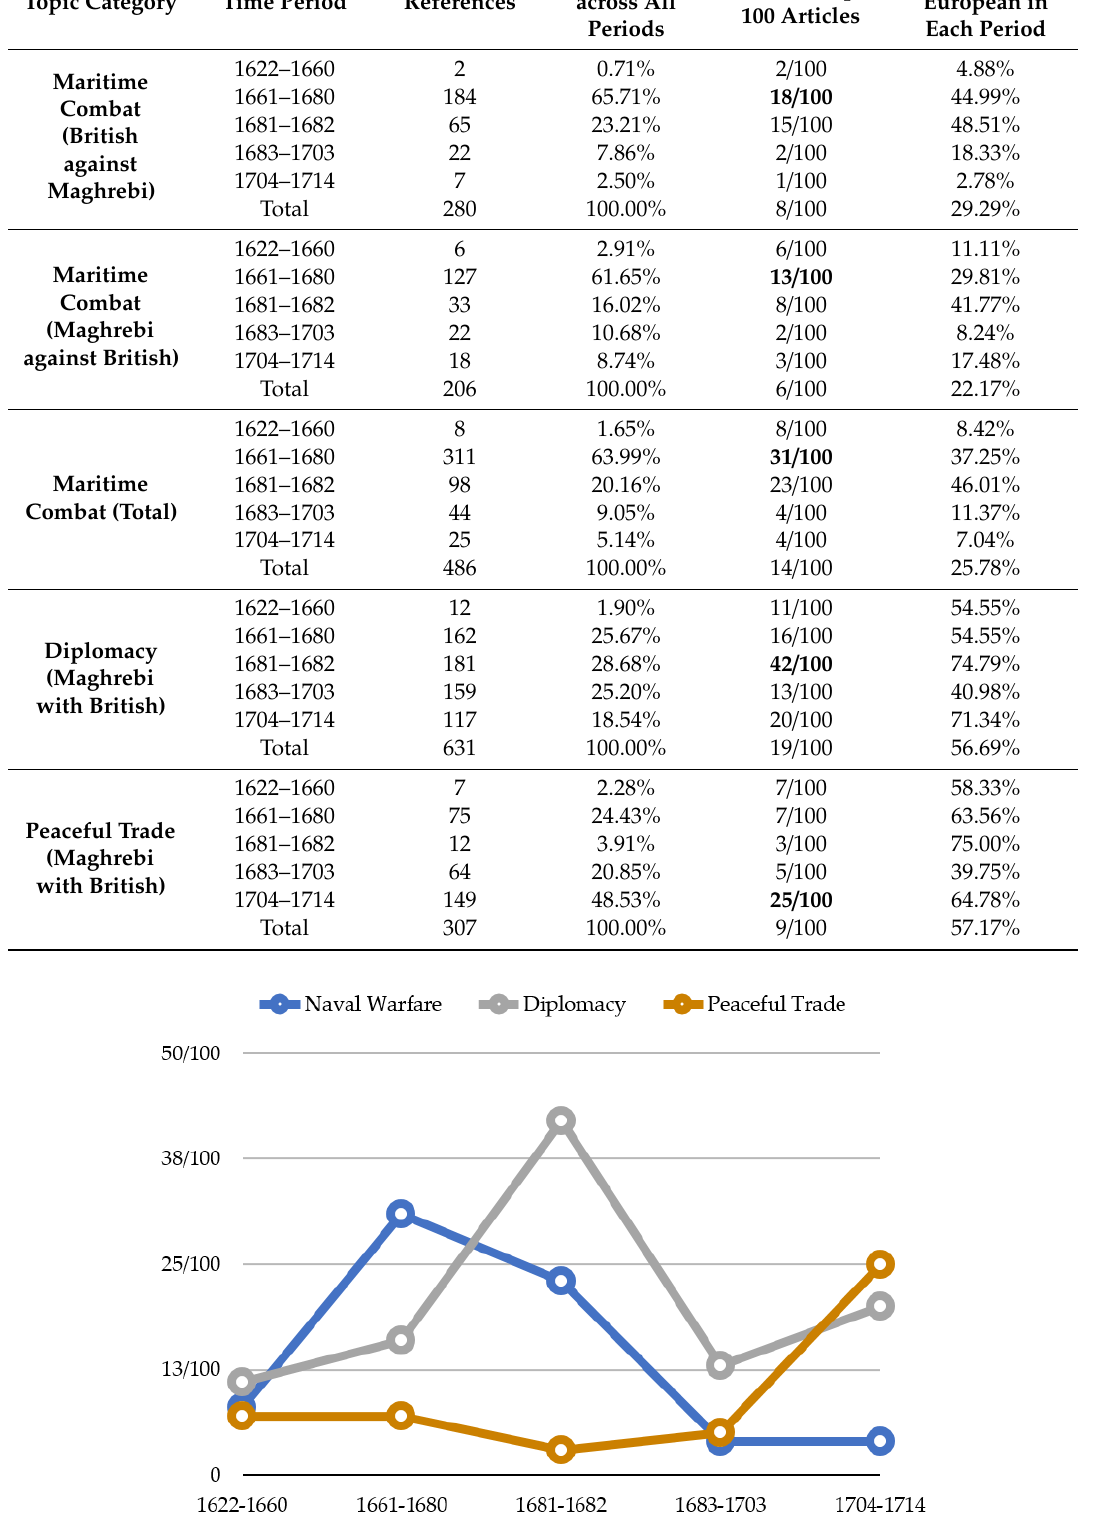
Figure 4. References to maritime combat, diplomacy and trade by period (British relations